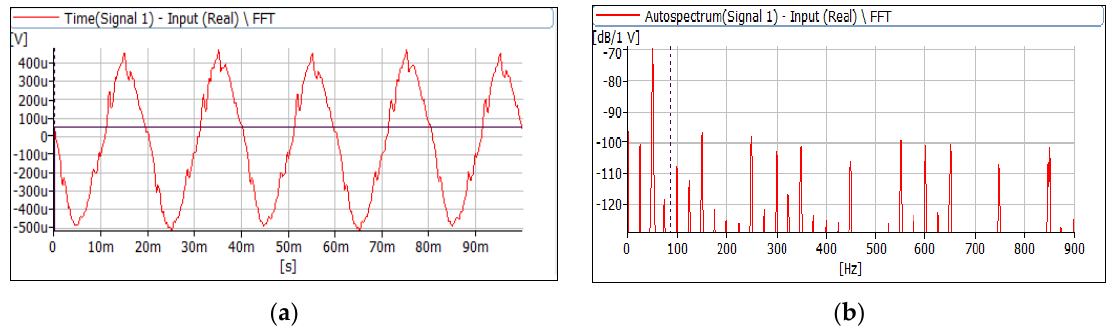
Figure 9. Signal delivered by PULSE acquisition system; ( a ) emf delivered by flux coil sensor, ( b ) signal spectrum delivered for the healthy machine.